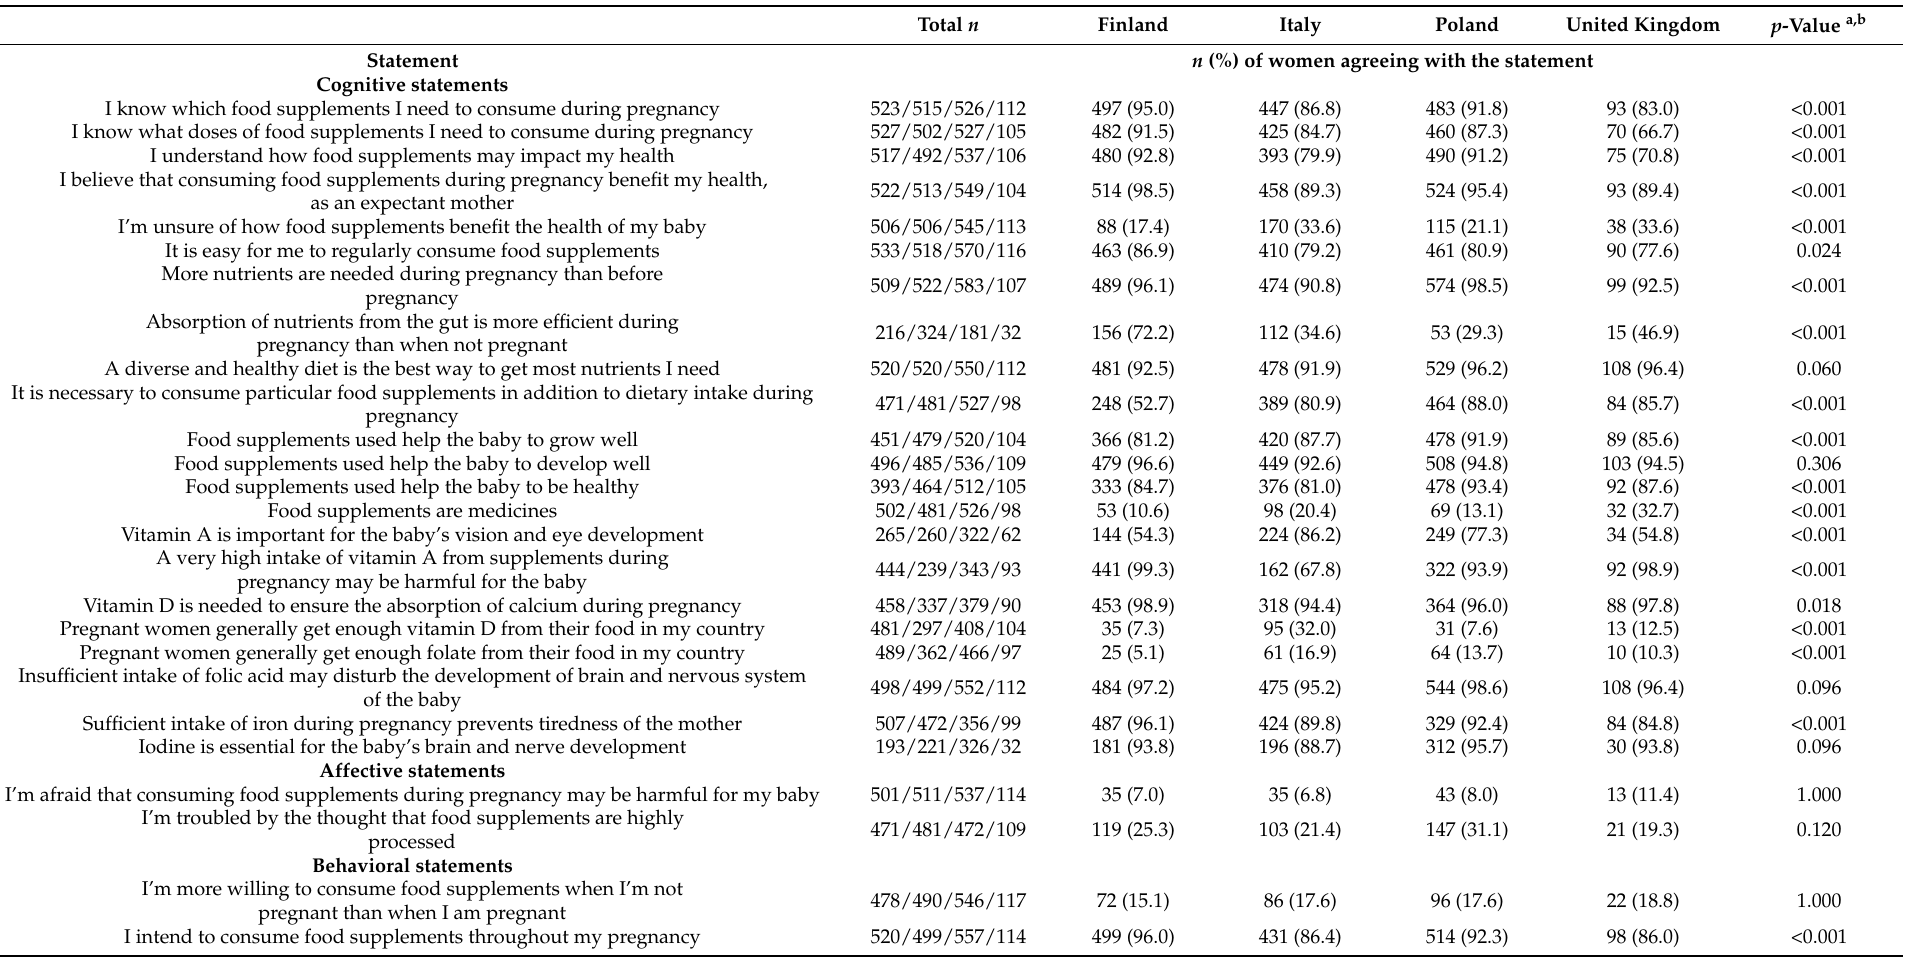
Table 4. Proportion of women agreeing with the statements regarding beliefs about and intention to use food supplements during